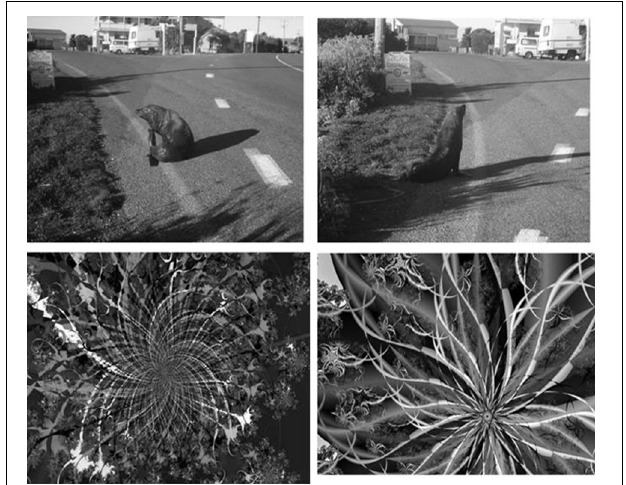
FIGURE 1 | Examples of pairs of images used as old and new items in Experiment 1 (scenes on top, fractals on the bottom).